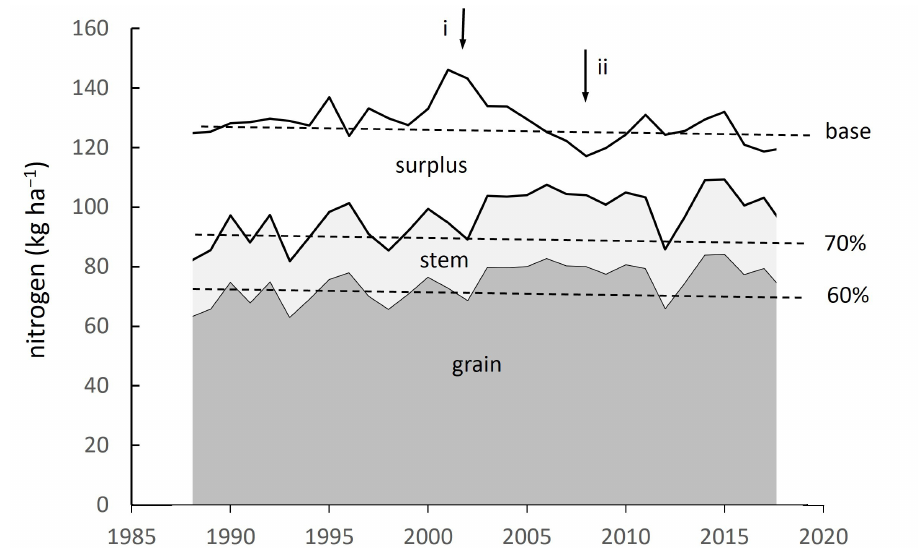
Figure 3. Trends for all cereals in nitrogen fertiliser (N-input, upper line) from the annual census [39], and estimated grain and stem nitrogen, based on nominal grain N content and N harvest index (Materials and Methods), and N-surplus (the residual), horizontal dashed lines showing N-input at the 1990 base for emissions, and nominal emissions targets of 70% and 60% of the base; arrows show years of (i) the largest and (ii) the smallest